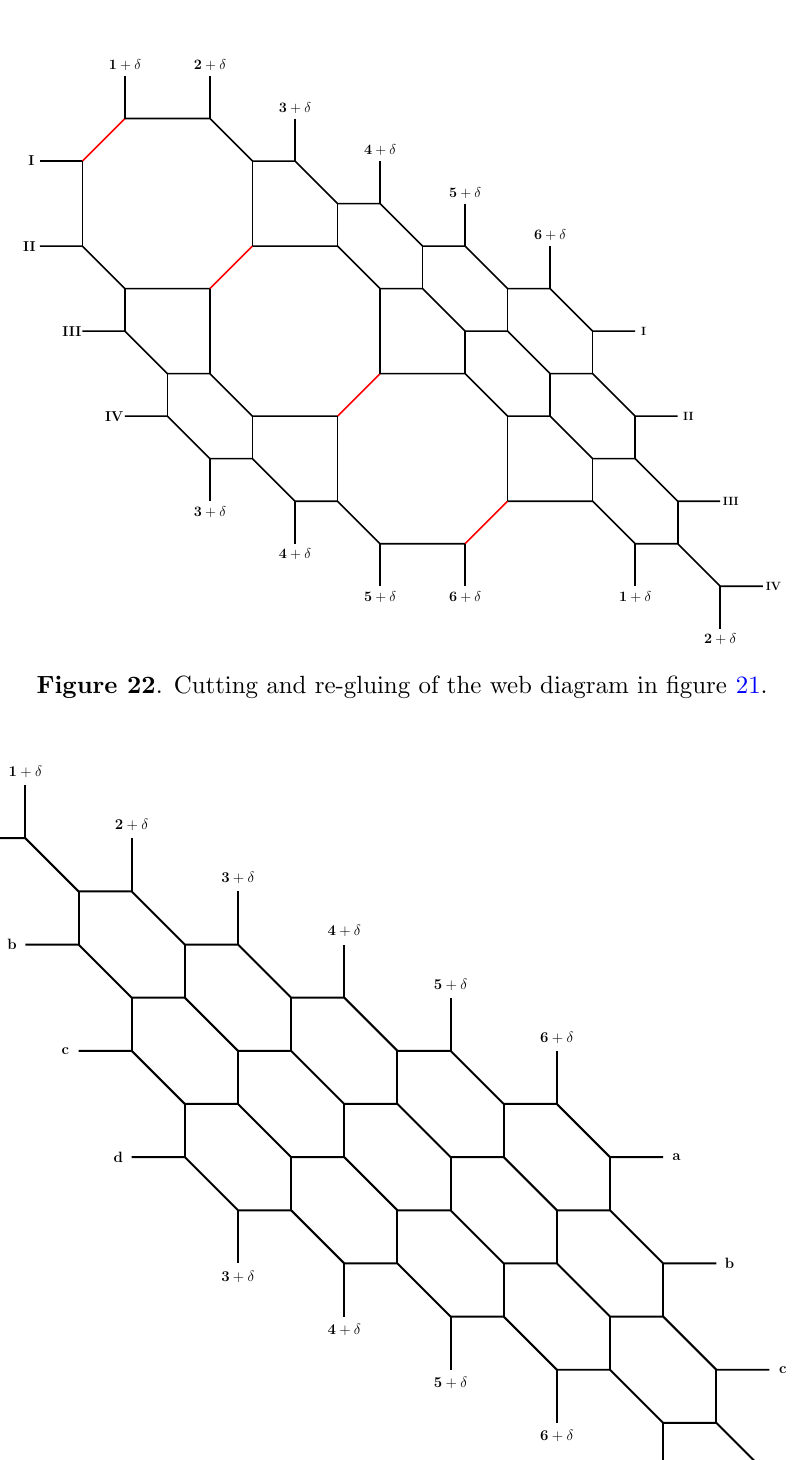
Figure 23 . Toric web diagram with ( N; M ) = (6 ; 4) and shift (cid:14) (cid:0) 2.